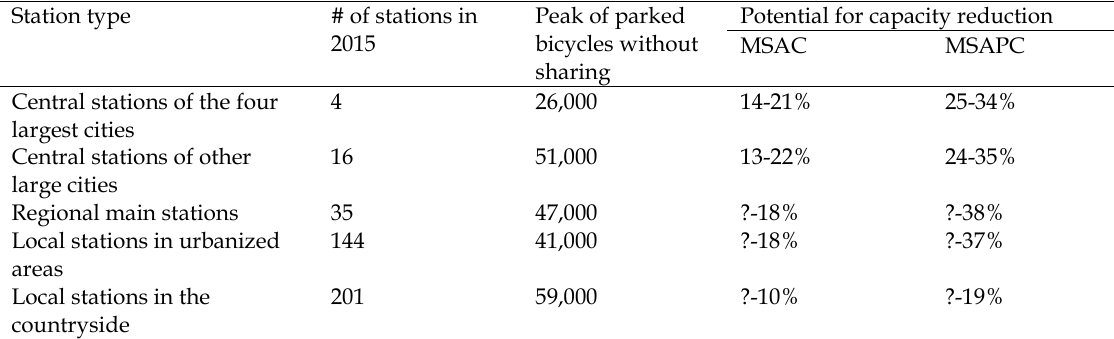
Potential capacity reduction for different station